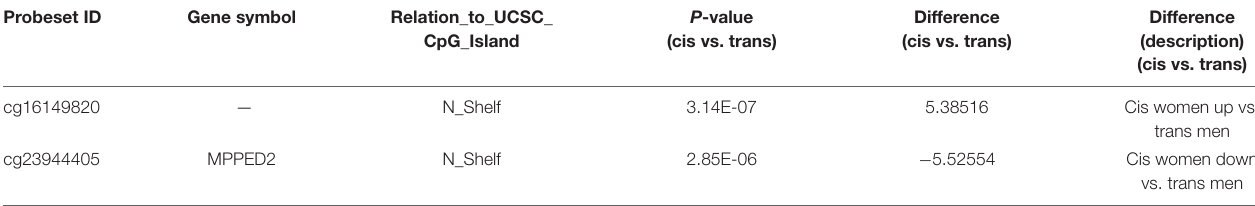
TABLE 2 | The 2 CpGs that passed statistical correction (FDR p < 0.05; fold change ≥ 2.0) in the population assigned female at birth. Probeset ID